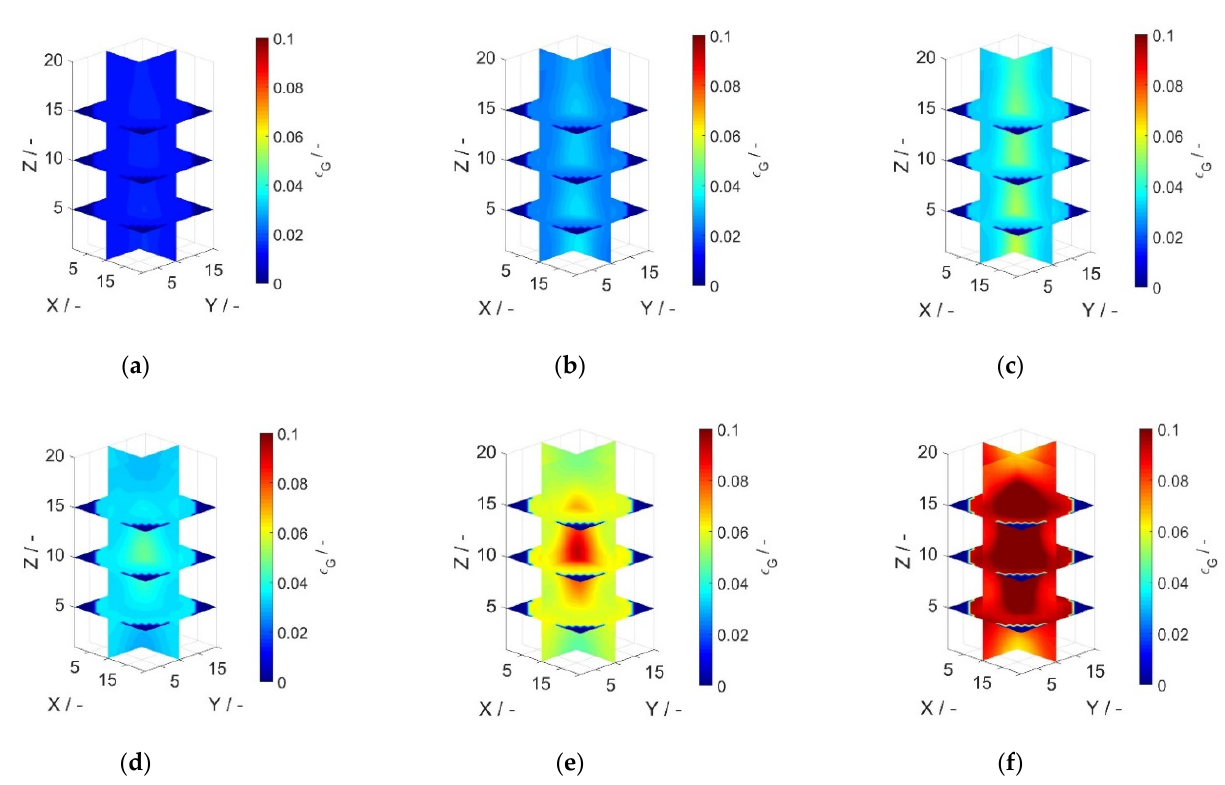
Figure 7. ECVT visualization of the local gas holdup for an aerated empty tube at u G = ( a ) 5.2 × 10 − 3 ms − 1 ( b ) 10.3 × 10 − 3 ms − 1 and ( c ) 15.5 × 10 − 3 ms − 1 , and a packed column with 6 mm cubic on the tip structures with H/D = 1.81 at u G = ( d ) 5.2 × 10 − 3 ms − 1 ( e ) 10.3 × 10 − 3 ms − 1 and ( f ) 15.5 × 10 − 3 ms − 1 .